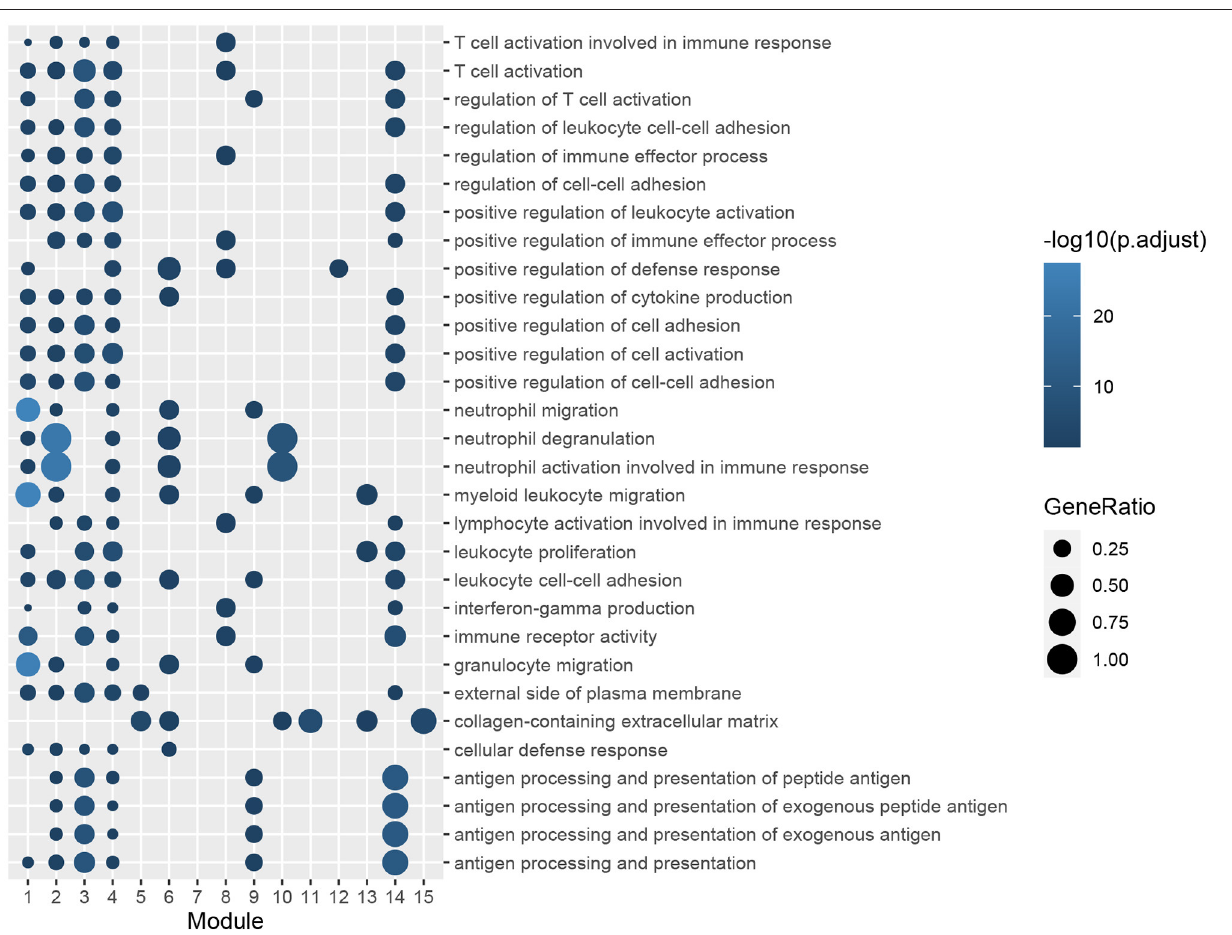
FIGURE 4 | GO enrichment analysis of genes in functional modules. The color gradation represents the significance of the enrichment for each indicated GO term. The enrichment increased significantly, when going from a dark to a light shade. The sizes of the circles indicate the proportions of genes in each functional module present among the entered GO